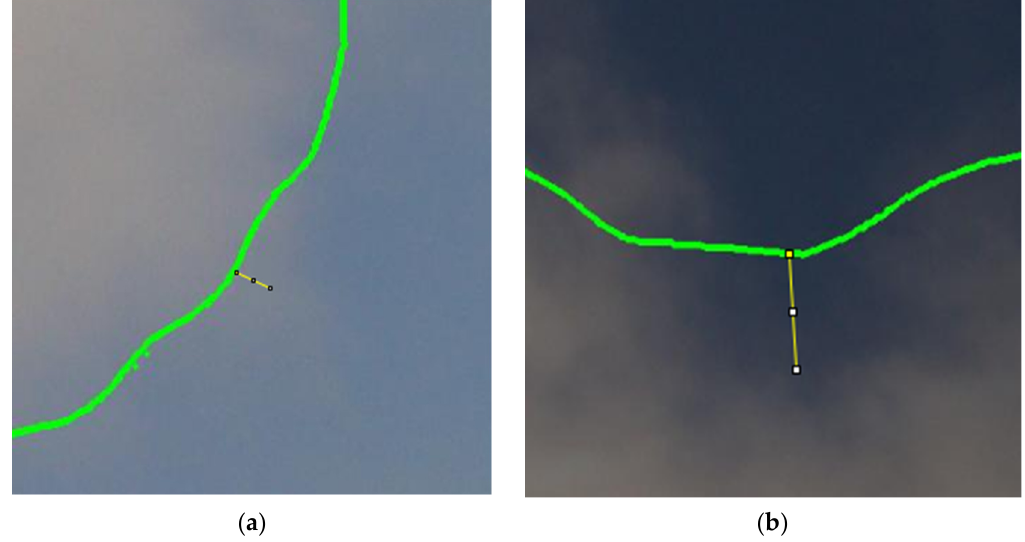
Figure 11. Example measurements extending ( a ) outwards 26 pixels. and ( b ) inwards 83 pixels.